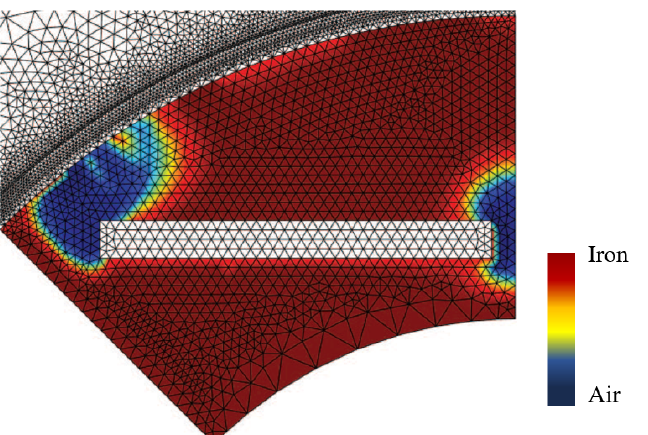
Figure 13. Illustration of density-based topology optimization for the rotor core of an interior permanent magnet synchronous machine, adapted from [9].